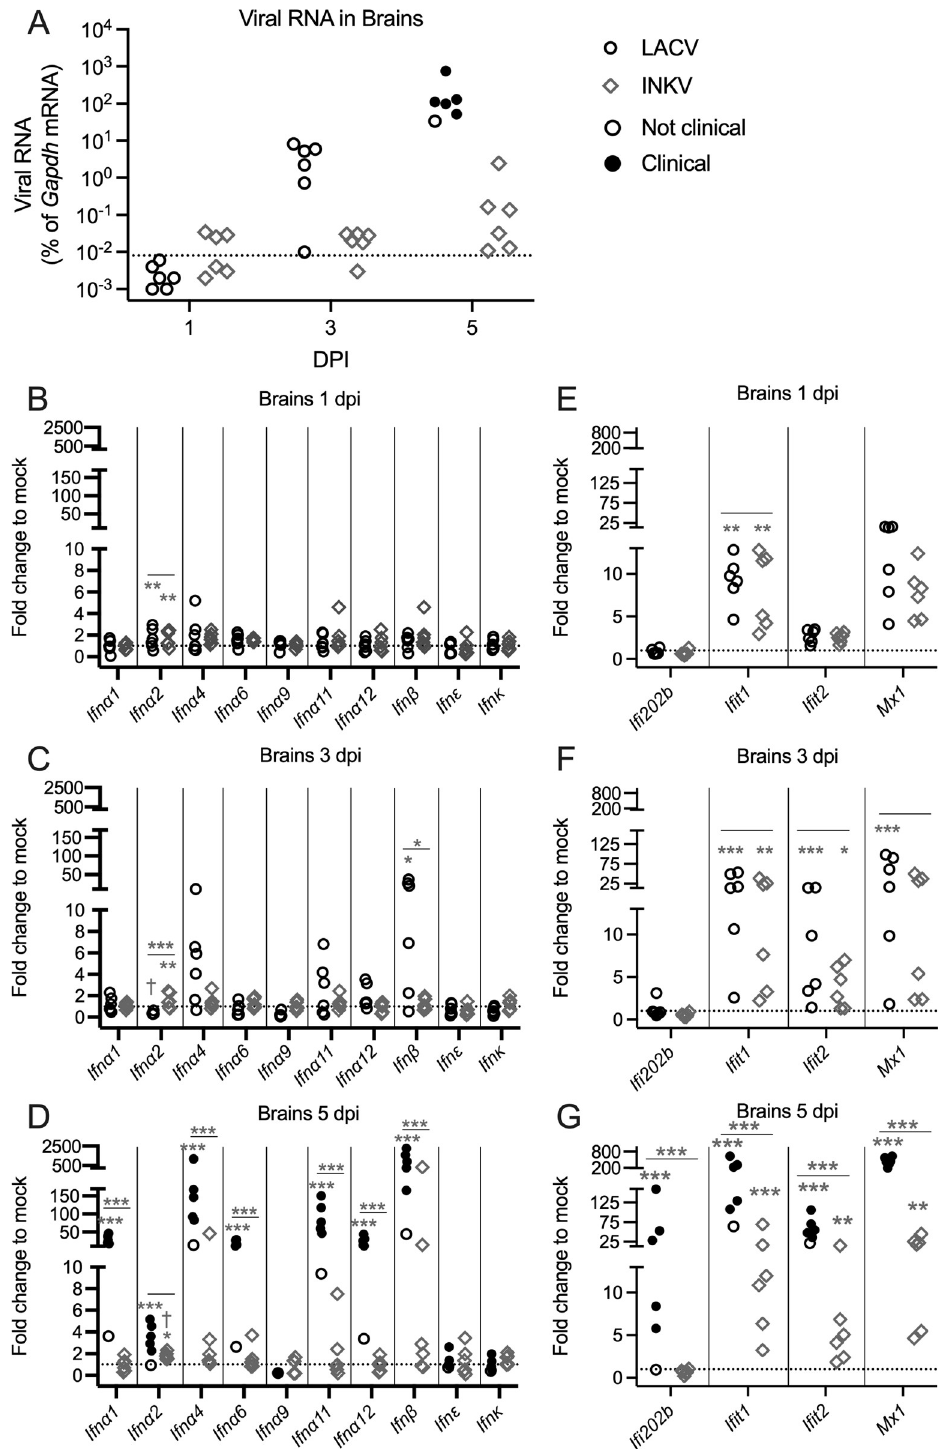
Fig 4. IFN response to LACV and INKV in the brains. A) Viral RNA values are the same as Fig 1A and 1I, but are represented here for a direct comparison of virus in LACV-infected and INKV-infected mice at 1, 3, and 5 dpi. IFN mRNA expression of 10 IFNs in the brains of LACV- and INKV-infected mice at (B) 1 dpi, (C) 3 dpi, and (D) 5 dpi. ISG mRNA expression in the brain was compared between LACV- and INKV-infected mice at (E) 1 dpi, (F) 3 dpi, and (G) 5 dpi. B-G) Dotted lines indicate fold change = 1. One-way ANOVA analyses were performed on